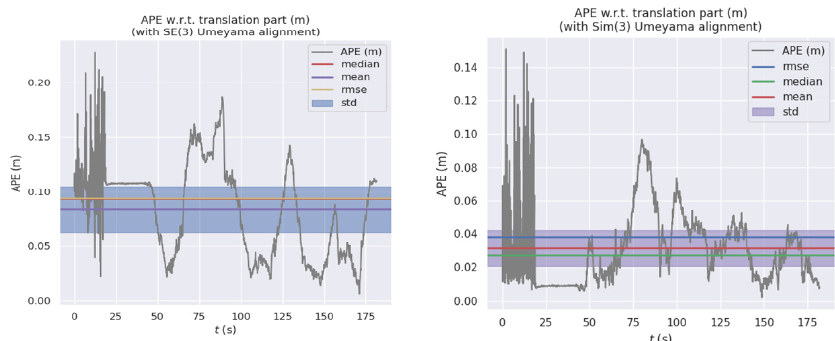
Figure 7. The comparison in space attitude of two algorithms in the EUROC dataset.